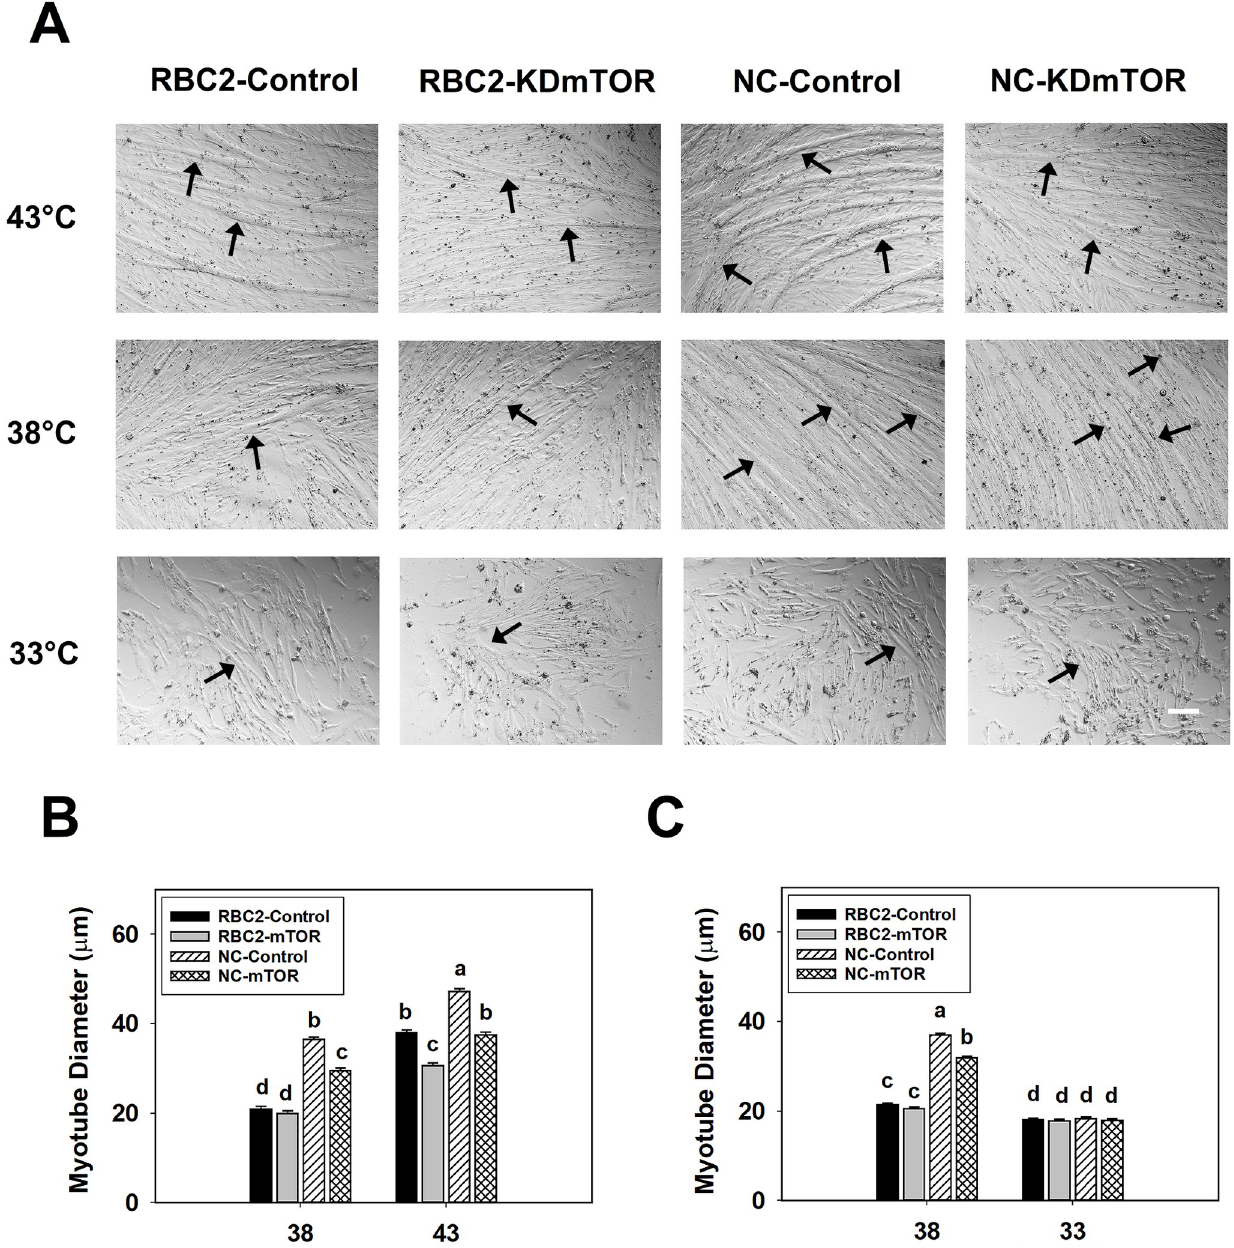
Fig 6. Effect of heat or cold thermal stress and siRNA-mediated knockdown of mTOR at the beginning of differentiation on the diameter of myotubes formed by RBC2 and NC line SCs. (A) Satellite cells from the RBC2 and NC lines proliferated normally at 38, 43, or 33˚C and transfected with either a negative control siRNA (Control) or a siRNA targeting mTOR (KD mTOR) at 72 h of proliferation; photomicrographs were taken at 48 h of differentiation. (B) Diameter of myotubes in the RBC2 and NC lines at 38 or 43˚C as shown in (A). (C) Diameter of myotubes in the RBC2 and NC lines at 38 or 33˚C as shown in (A). Each graph bar represents a mean diameter of the myotubes, and each error bar represents a standard error of the mean value. Mean values with different letters are significantly different ( P � 0.05). Black arrows highlight the representative myotubes. Scale bar (White) = 100 μ